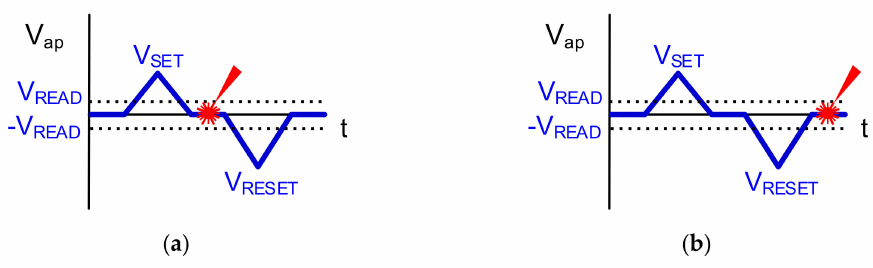
Figure 4. Laser test ( a ) With the device in LRS and ( b ) With the device in